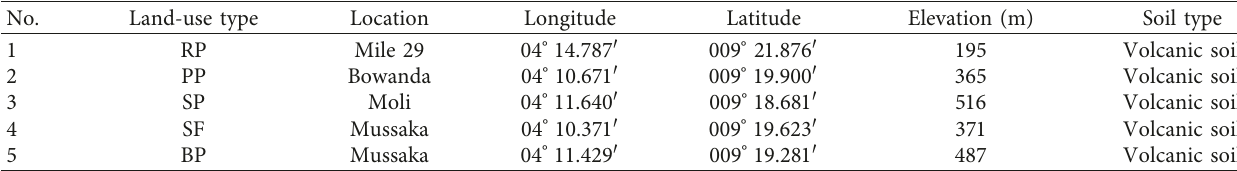
Table 1: Description of sampling sites used for the